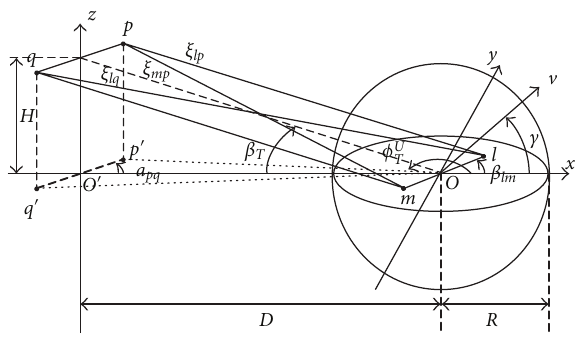
Figure 3: The 2 × 2 MIMO channel model with LOS path.